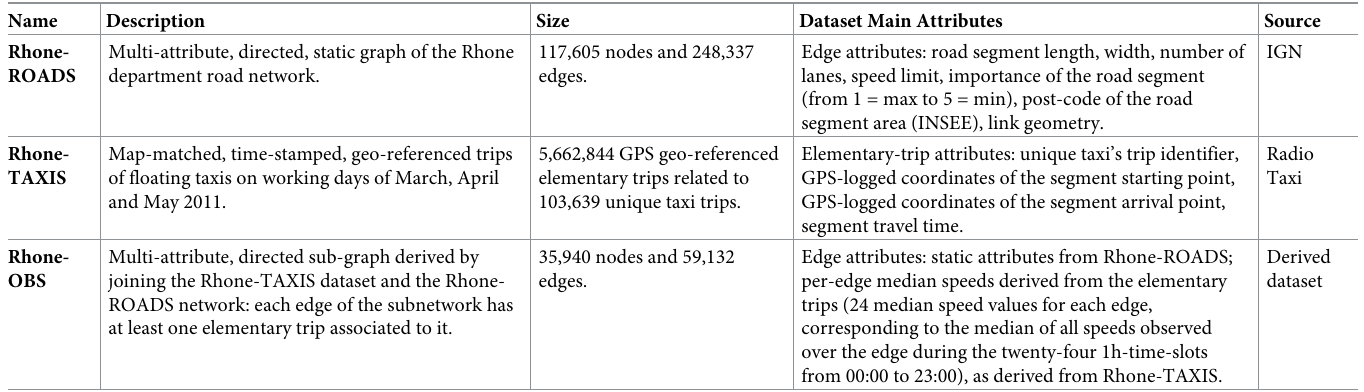
Table 1. Description of the considered